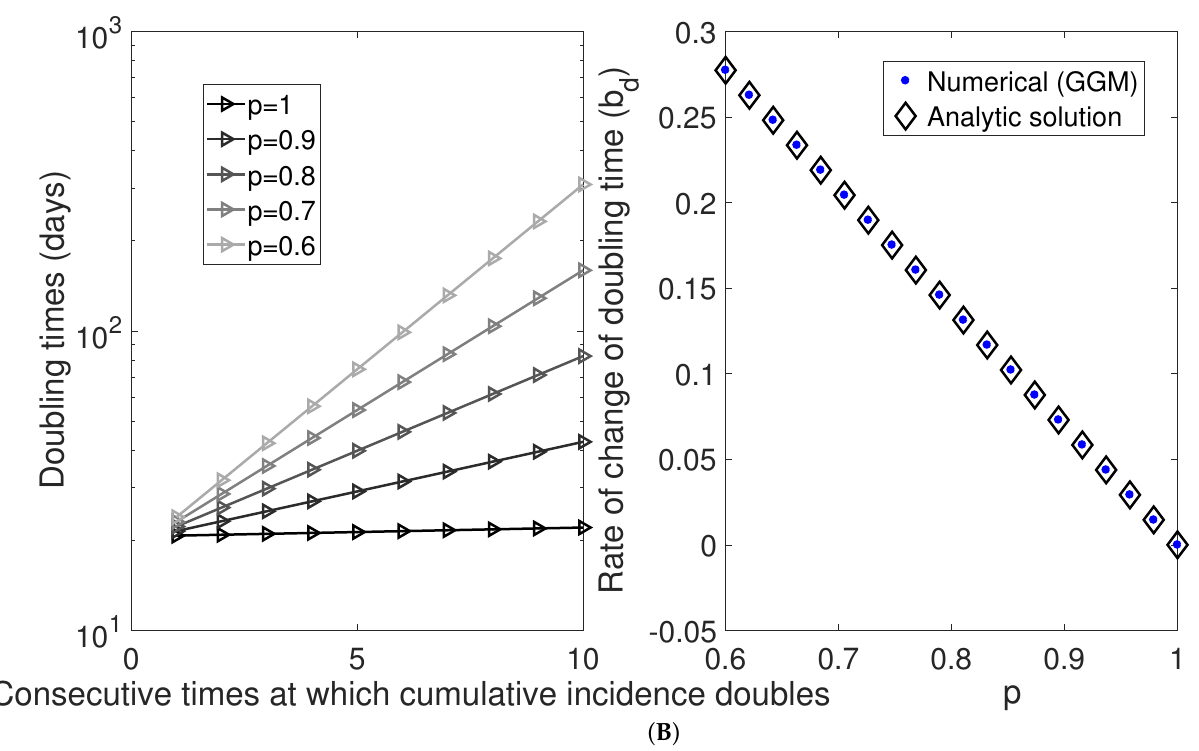
Figure 3. Comparison of the numerical and analytic estimates of the rate of change of doubling ti-mes assuming growths according to the generalized-growth model. ( A ) The sequence of “doubling times” from the GGM and ( B ) consistent point estimates of rate of change of doubling times are obtained from the numerical and analytic results for a range of values of the scaling of growth parameter, p , with b d : = ( 1 − p ) ln2.